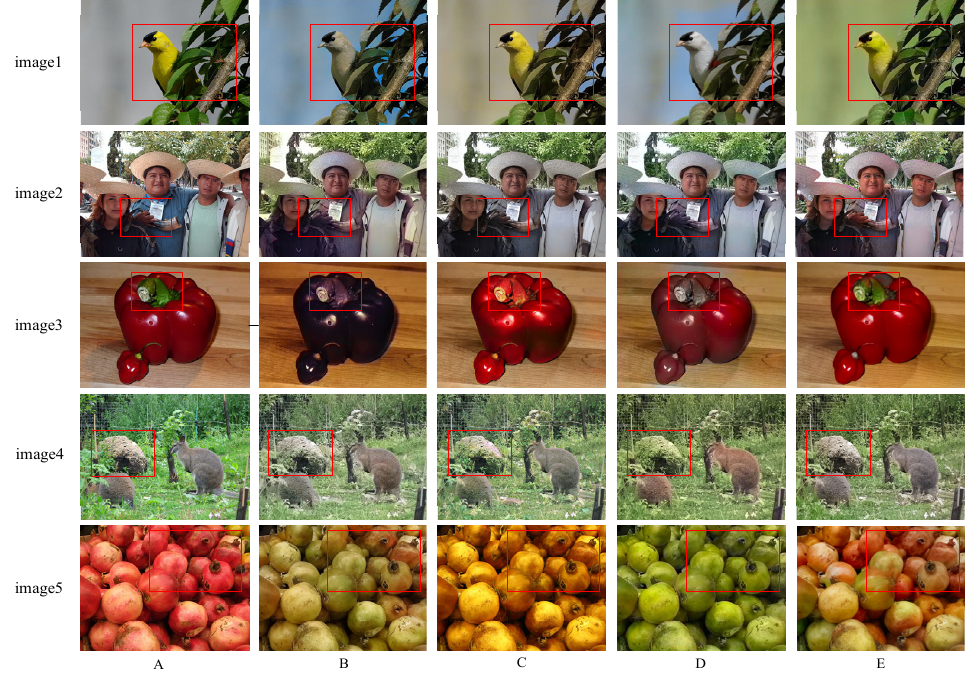
Figure 6. Comparison of the coloring effects of different colorization methods. ( A ) Real image; ( B ) Ref. [13]; ( C ) Deoldify; ( D ) ChromaGAN; ( E ) proposed method. The red rectangular box represents the area where the colorization effect of each method differs greatly.